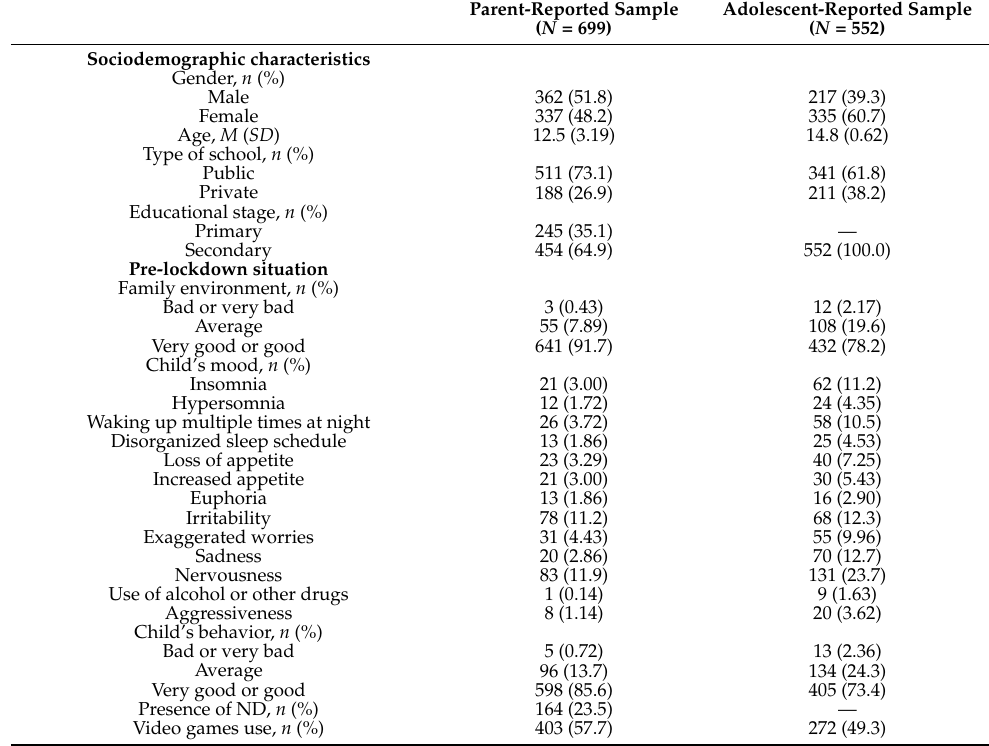
Table 1. Characteristics, life conditions, and COVID-related variables of the study